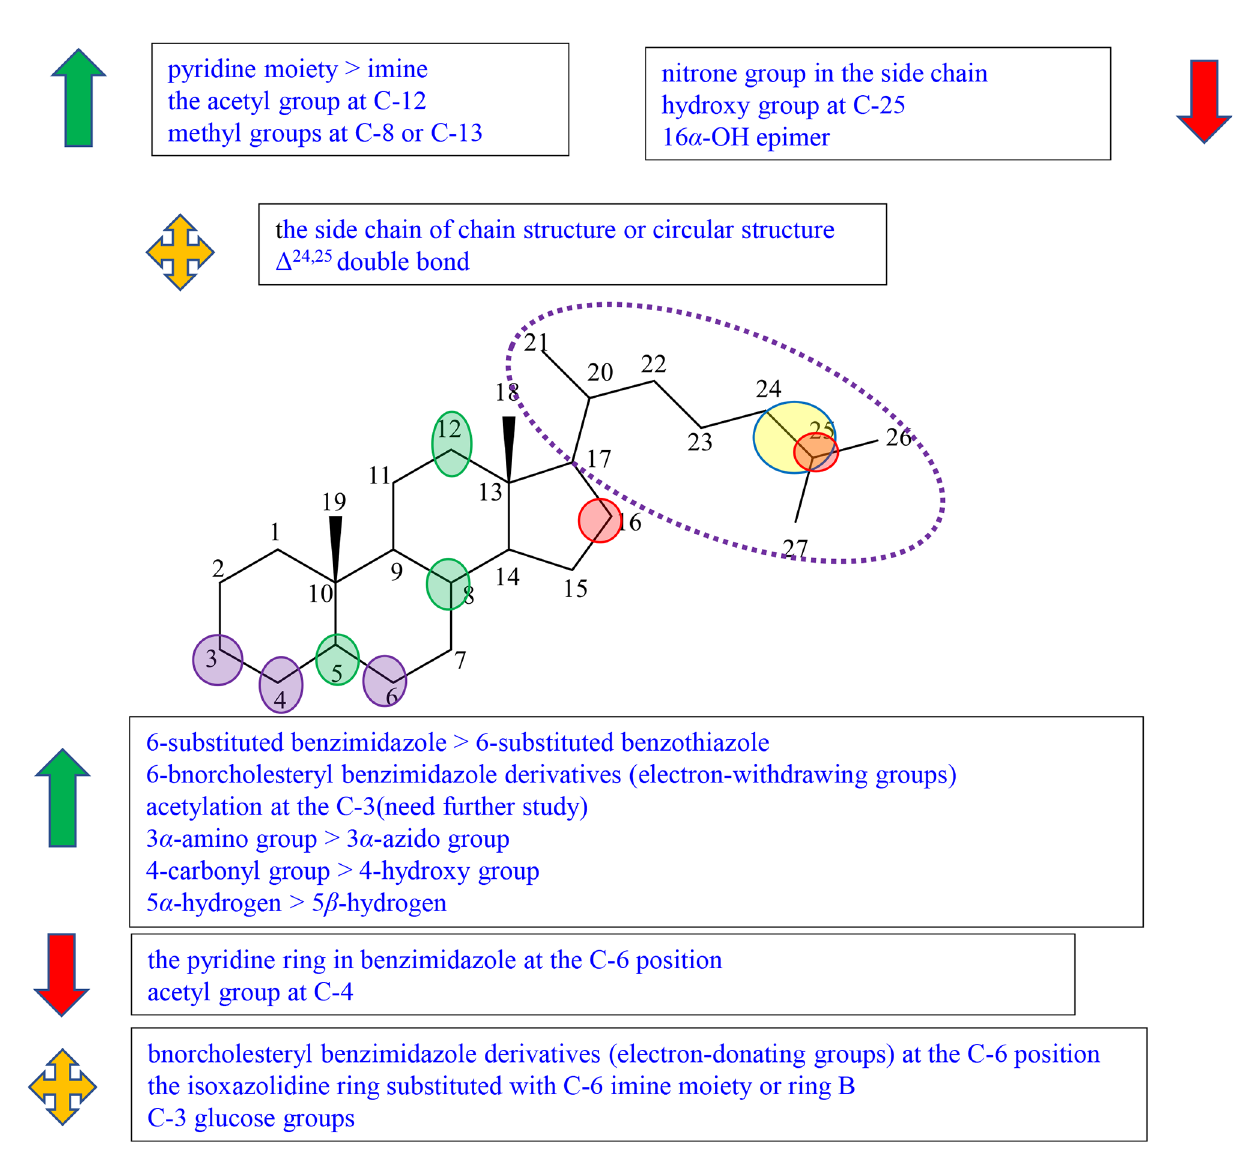
FIGURE 5 | Summary of Structure-activity Relationship of Cholestane Alkaloid